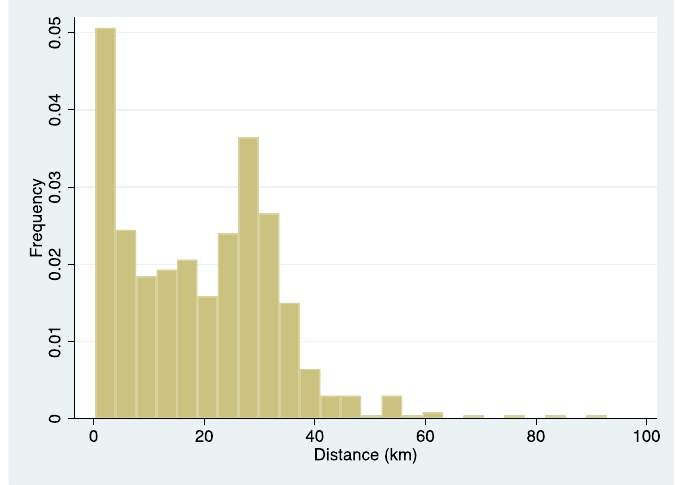
Figure 1. Histogram of the patient’s residential distance from the hospital.